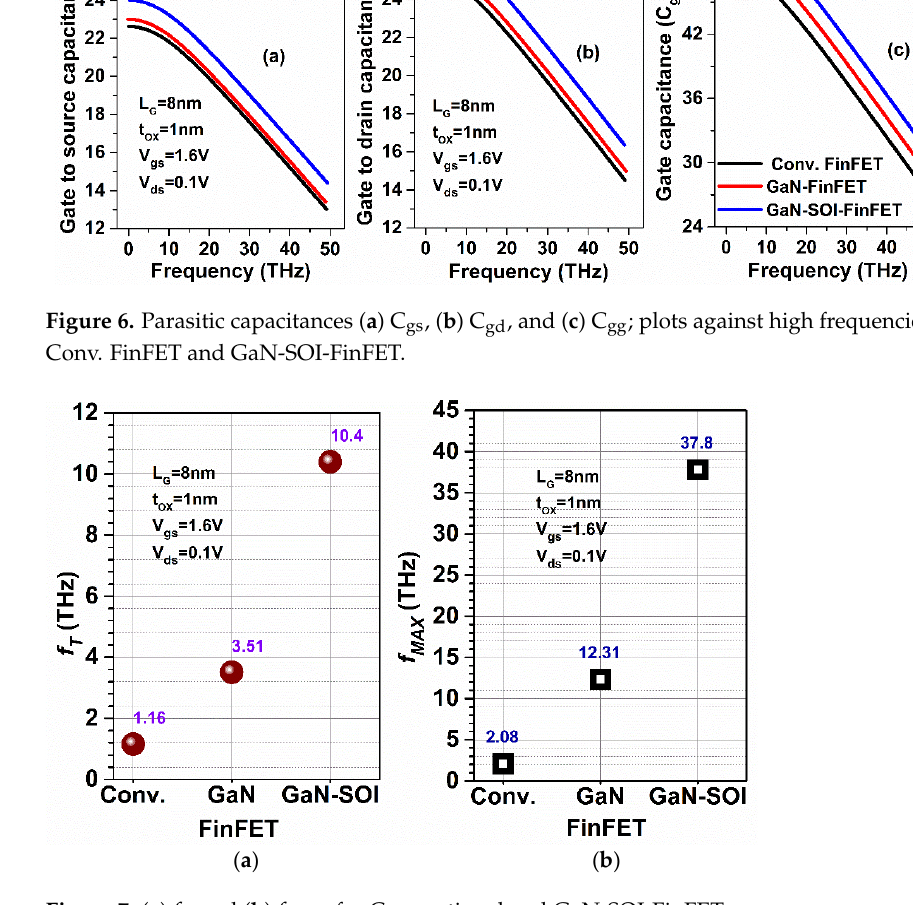
Figure 7. ( a ) f T and ( b ) f MAX for Conventional and GaN-SOI-FinFET.